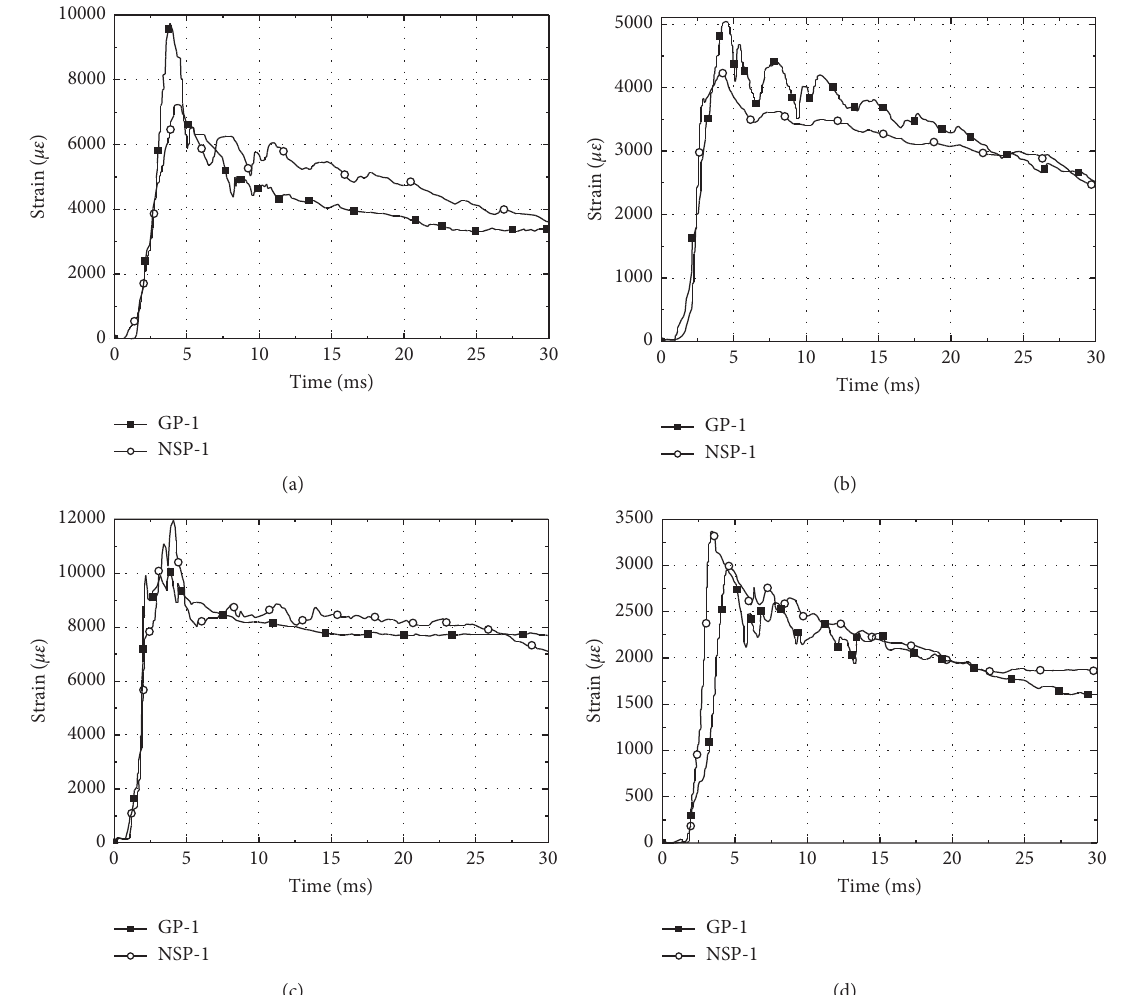
Figure 26: Comparison of strain time-history curves between experiment and numerical simulation of GP-1 at collection points under four working conditions. (a) ST1. (b) ST2. (c) ST3. (d) ST4.